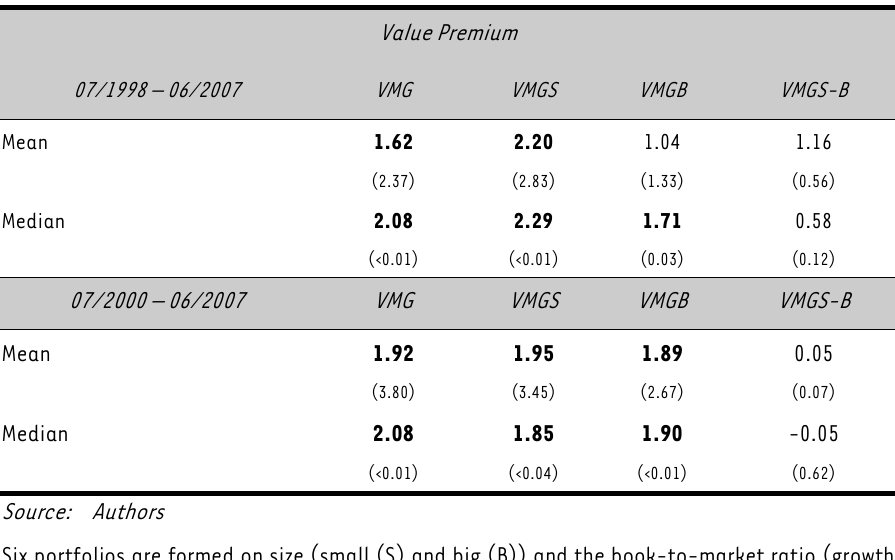
TABLE 1: Summary statistics for the value